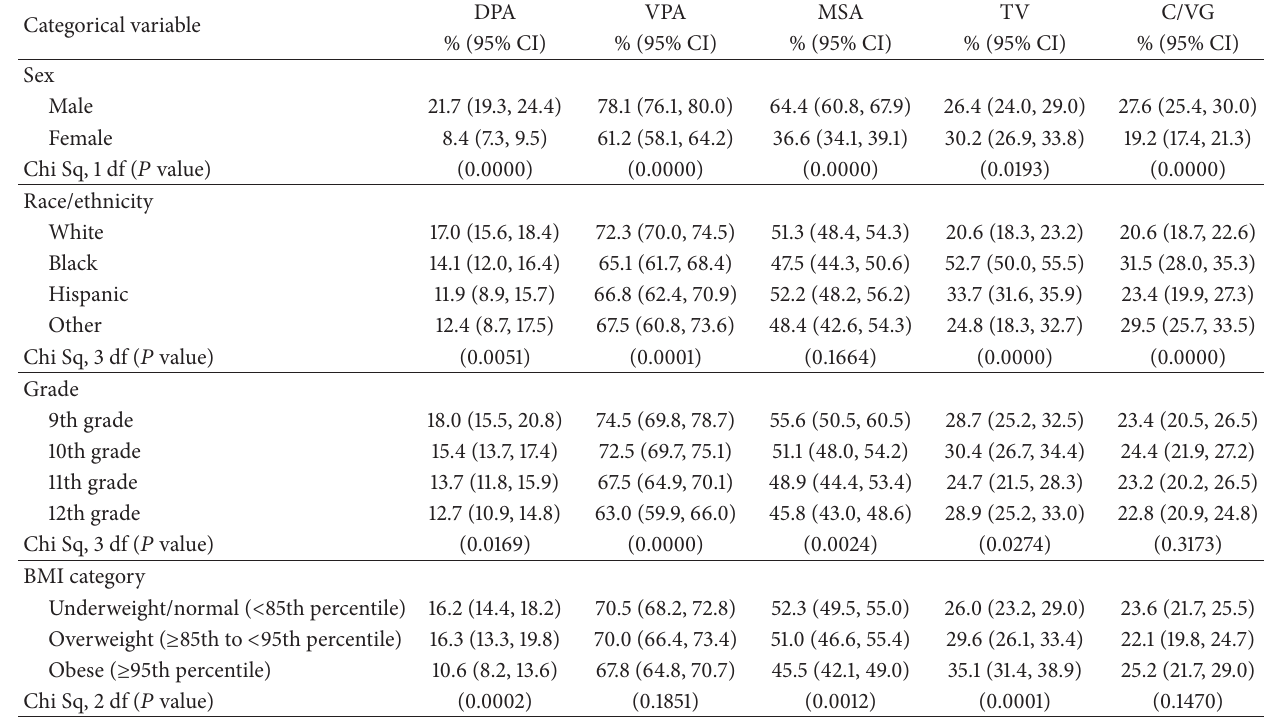
Table 3: Prevalence of participation in daily physical activity (DPA), vigorous physical activity (VPA), muscle-strengthening activity (MSA), television (TV) viewing, and computer or video game (C/VG) use, by demographic and BMI category among US high school